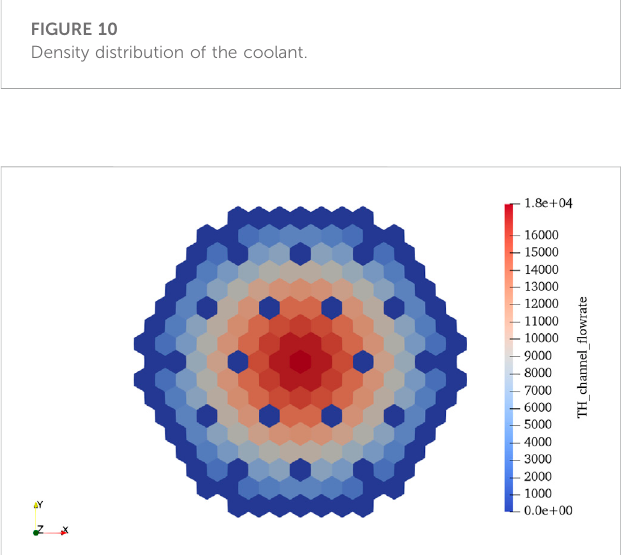
FIGURE 11 Flow rate distribution of the coolant.